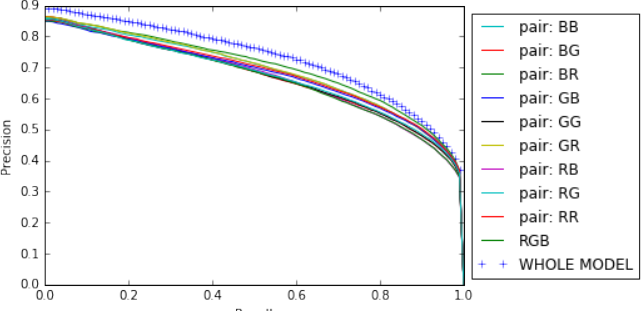
Figure 11. Precision–Recall curves for opposing color pairs, RGB color space and the whole model on the ECSSD dataset.